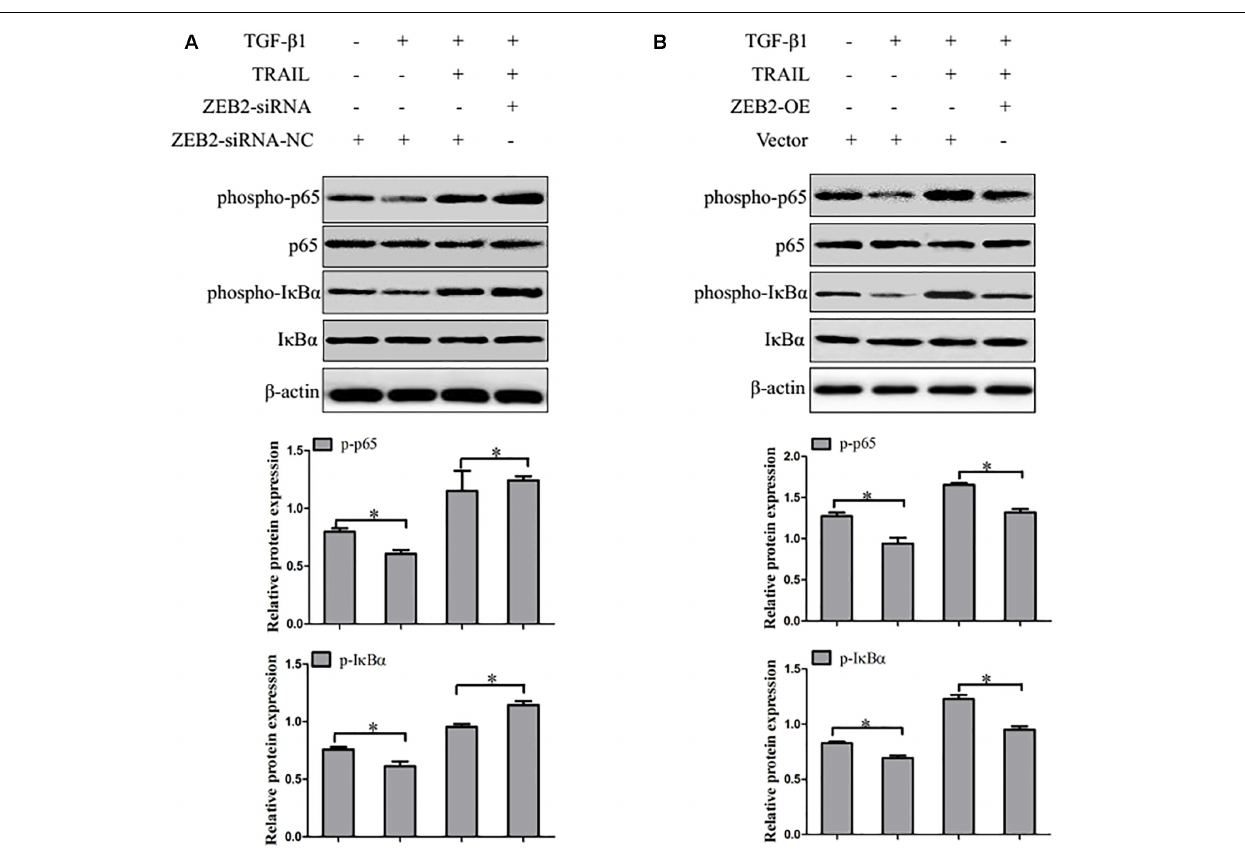
FIGURE 7 | ZEB2 negatively regulated the activity of NF- κ B. (A) The LX-2 cells transfected with ZEB2-OE, and then protein expression of the phospho-p65 and phospho-I κ B α was determined by Western blot analysis. (B) The LX-2 cells transfected wit ZEB2-siRNA, and then protein expression of the phospho-p65 and phospho-I κ B α was determined by Western blot analysis. The assays were performed at least three times with similar results. Data are shown as the mean ± SD ( n = 3) of one representative experiment. ∗ p < 0.05 versus normal